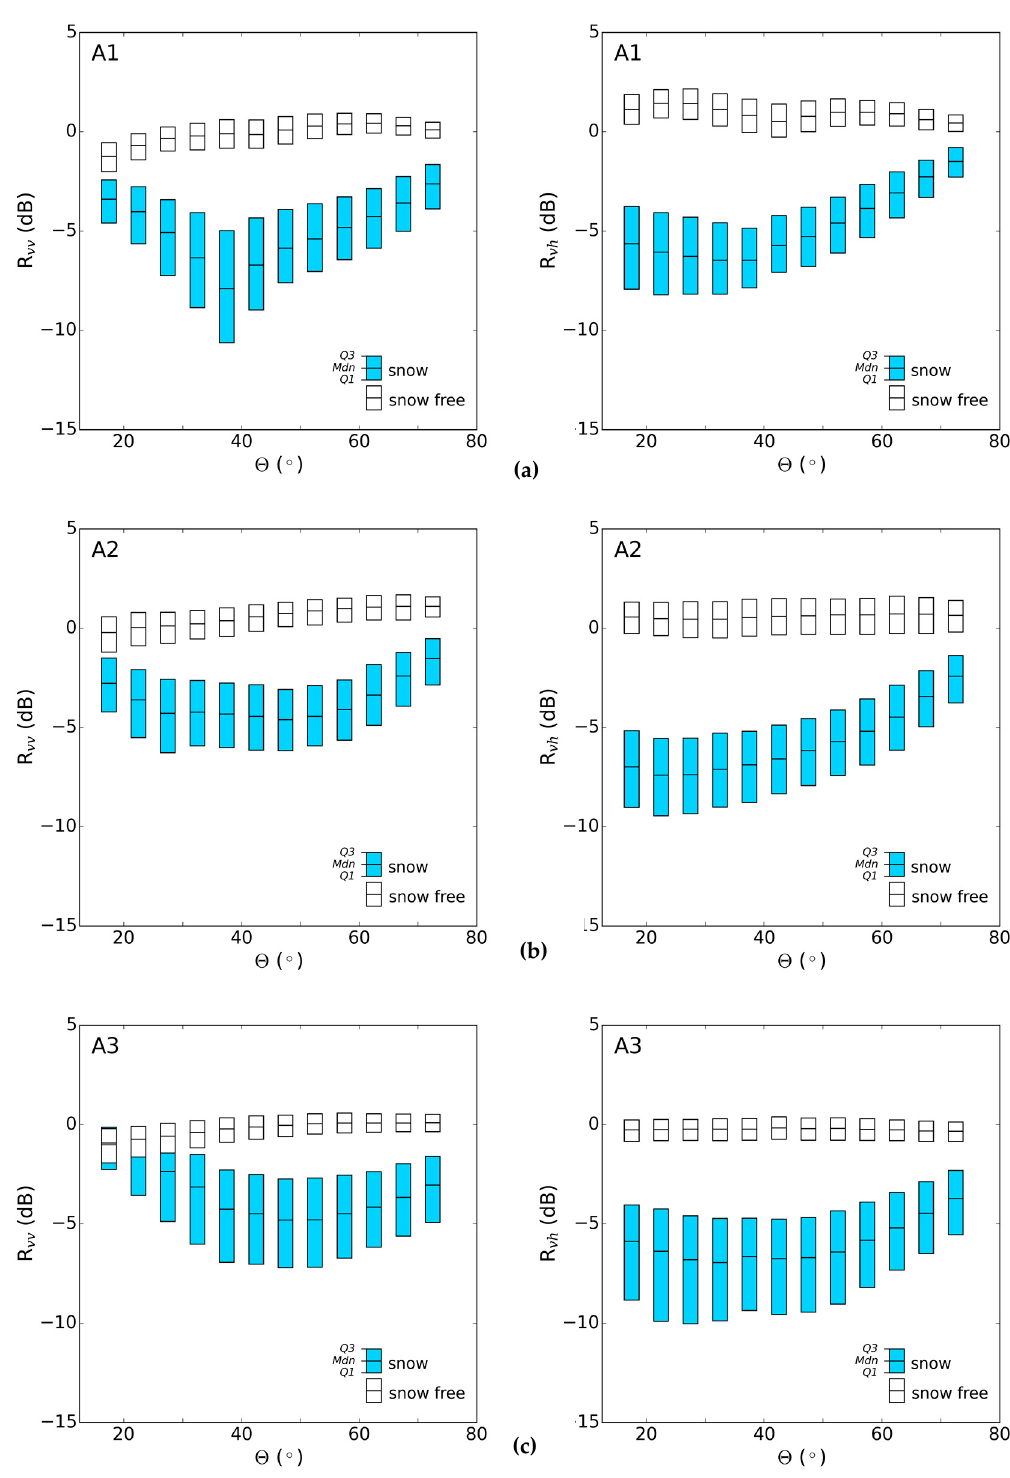
Figure 2. Backscatter ratio (median, Mdn, 1st and 3rd quartile) for S1 VV - and VH - polarized channels in dependence of the local incidence angle, θ , for areas classified as snow-free and snow-covered in Landsat images (see Section 3.2): ( a ) test site A1: Tröllaskagi; ( b ) test site A2: Ötztal Alps; ( c ) test site A3: Swiss Alps.